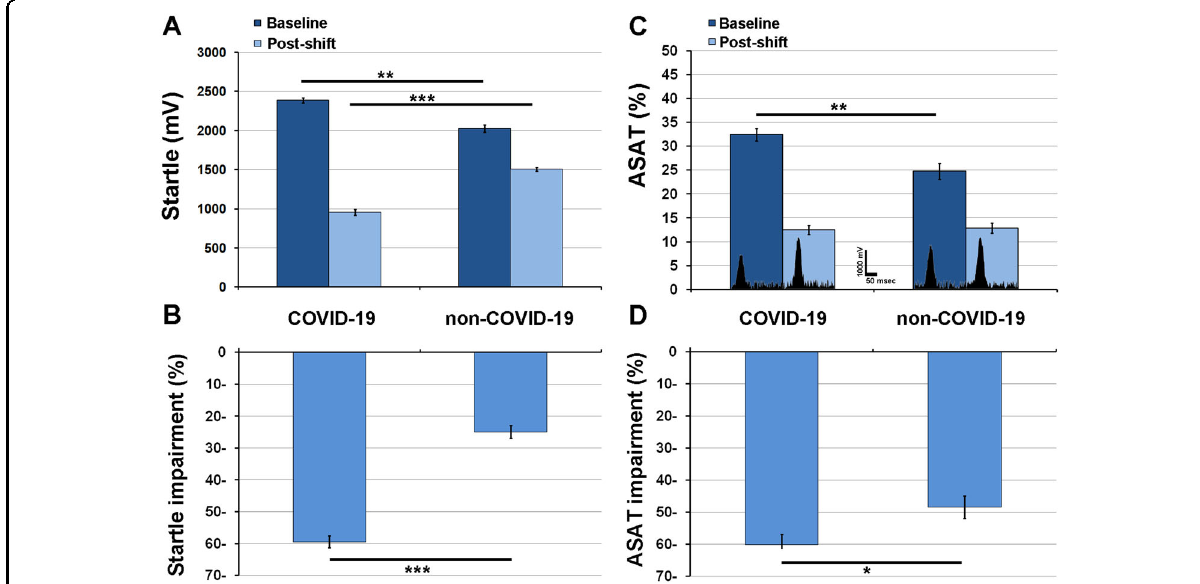
Fig. 1 COVID-19 physicians showed signi fi cantly larger startle and attention vigilance compared with non-COVID-19 physicians. A Baseline startle response followed by post-shift response in COVID-19 versus non-COVID-19 group. B The % impairment (100× (post-shift — baseline)/baseline) re fl ects the magnitude of impairment observed in the COVID-19 group, compared with non-COVID-19 group. ** P < 0.01, *** P < 0.0001 (two-sided t test). C Baseline and post-shift attention levels of COVID-19 compared with non-COVID-19 physicians. Representative EMG responses illustrate the inverse relationship between the inhibited response and the ASAT performance. D The % attention impairment (100 × (post-shift — baseline)/